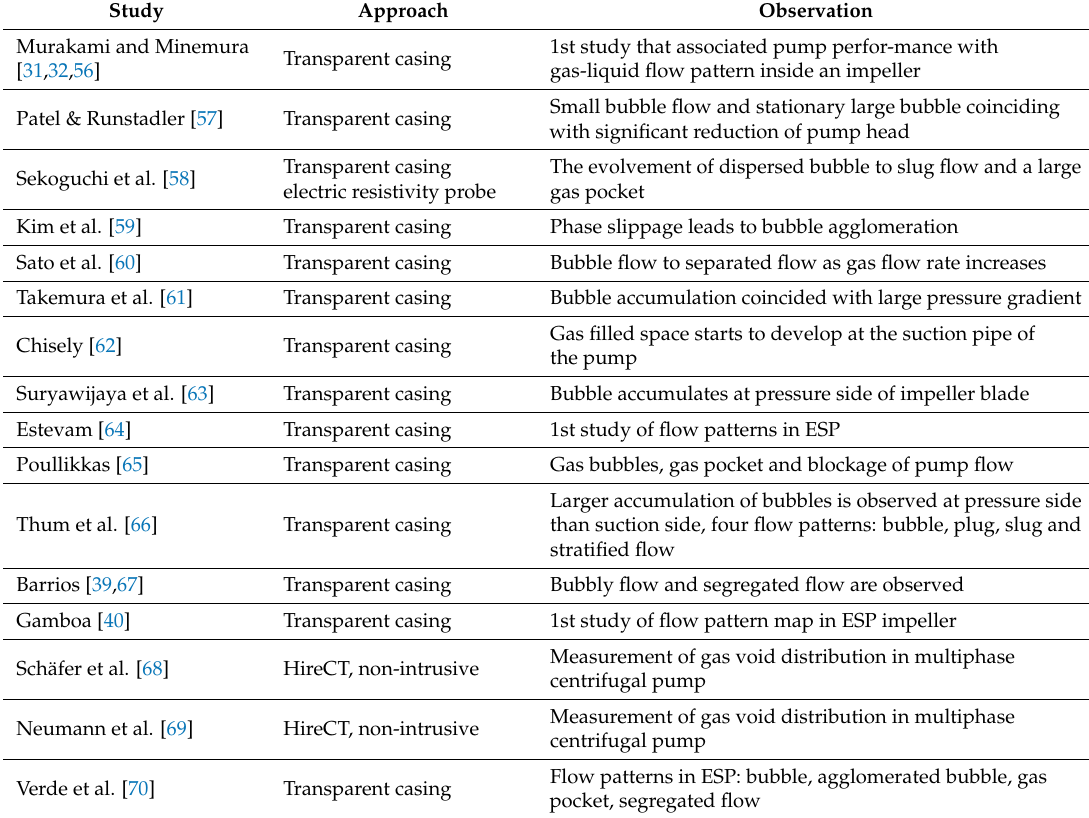
Table 8. Experimental studies on two-phase flow patterns inside a centrifugal